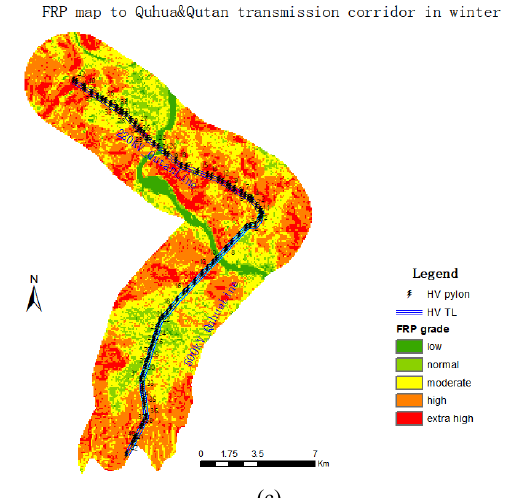
Figure 6 . FRP of HV power lines in 2018. (a) FRP map to the Diewu-500kV transmission corridor in June, (b) RP map to the Quhua & Qutan transmission corridor in September, (c) RP map to the Quhua & Qutan transmission corridor in